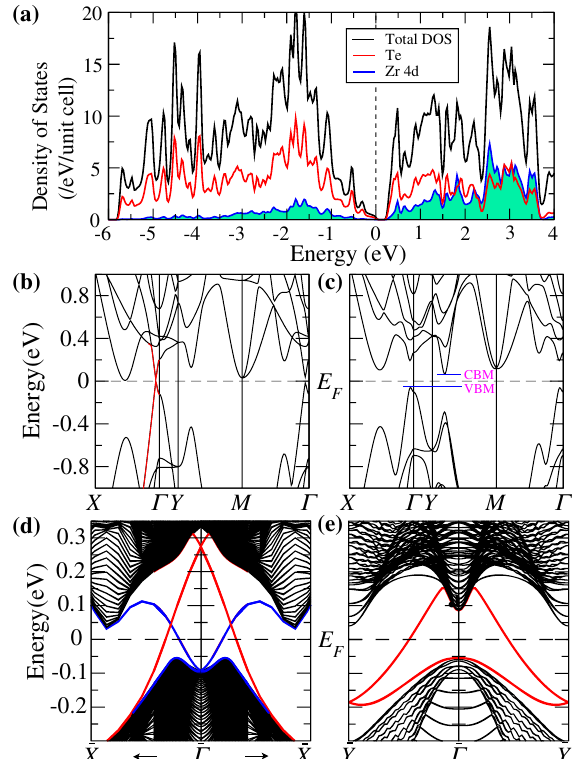
FIG. 3 (color online). The calculated electronic structures of single-layer ZrTe 5 . (a) The density of states. (b) and (c) The band structures without and with SOC, respectively. The valence-band maximum (VBM) and conduction-band minimum (CBM) defin- ing the indirect band gap are indicated in (c). (d) and (e) The calculated edge states for the x and y edges, respectively (see the main text for